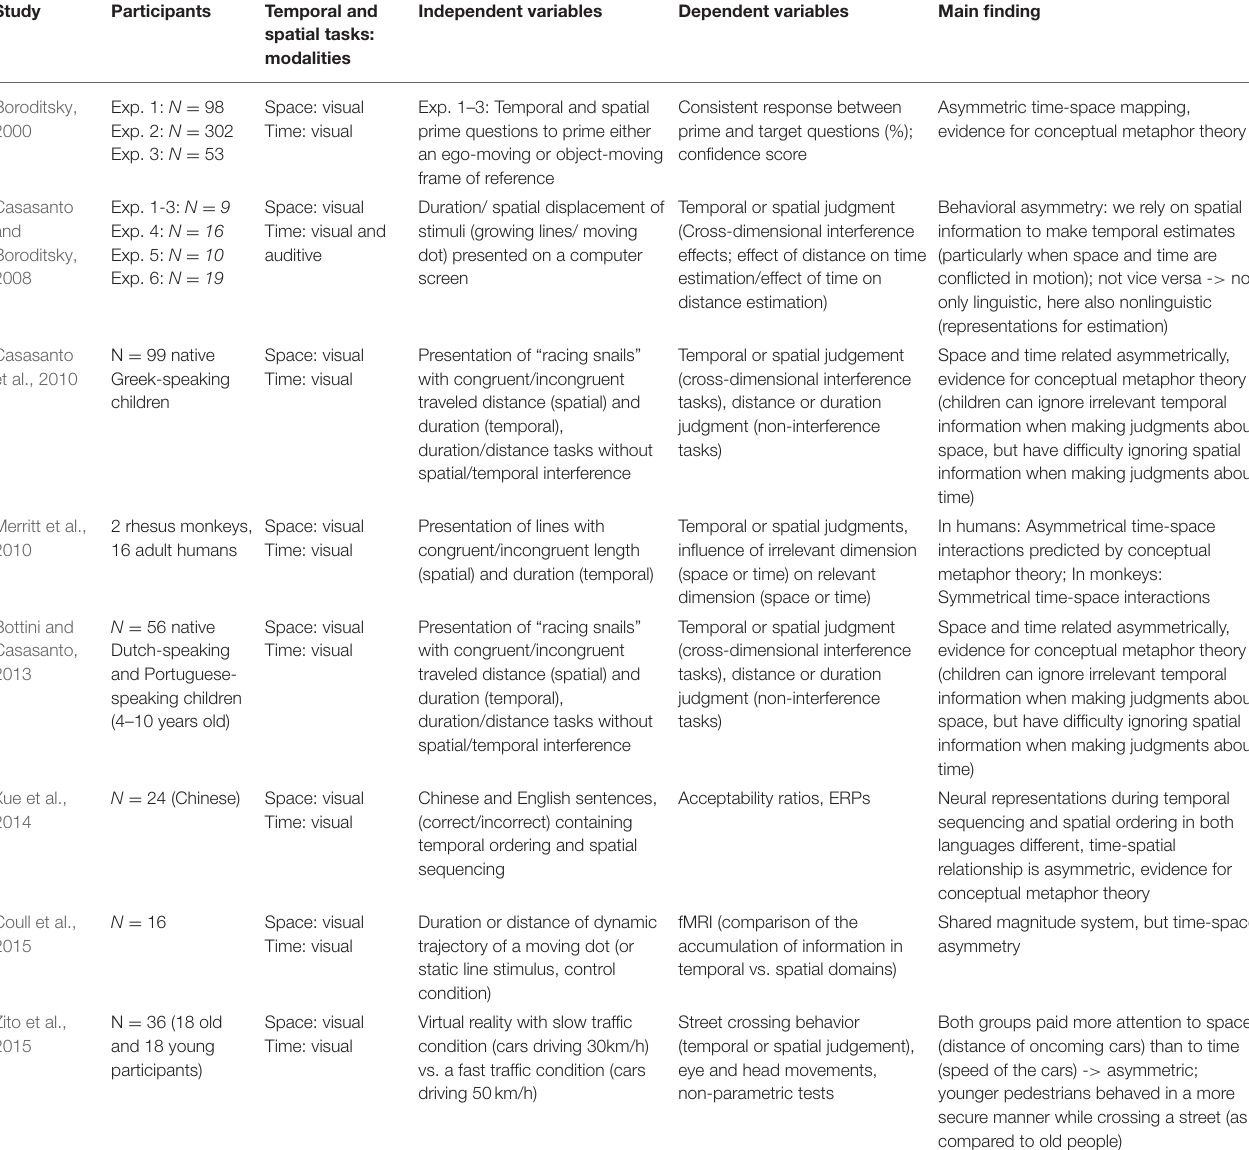
TABLE 1 | Studies supporting the conceptual metaphor theory and therefore an asymmetric time-space